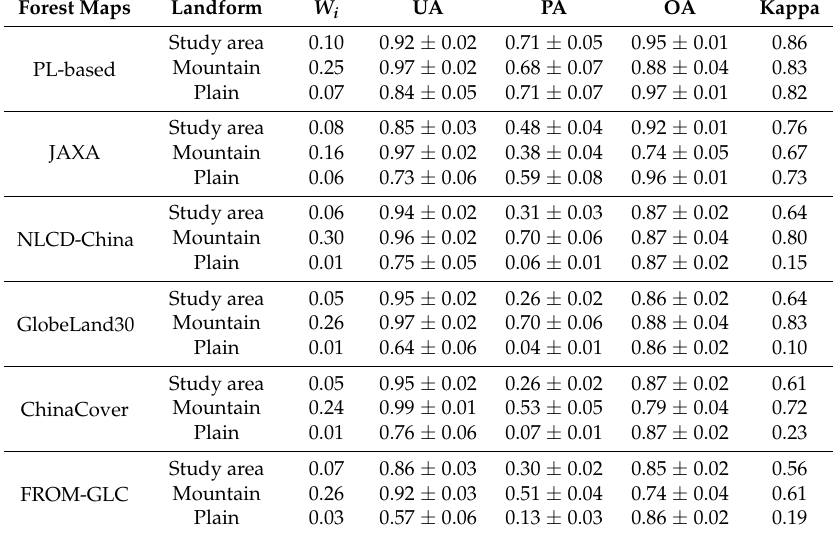
Table 2. Forest accuracy assessments of the PL-based and the other five forest maps. Accuracy measures are adjusted with the area of each stratum and presented by a 95% confidence interval.